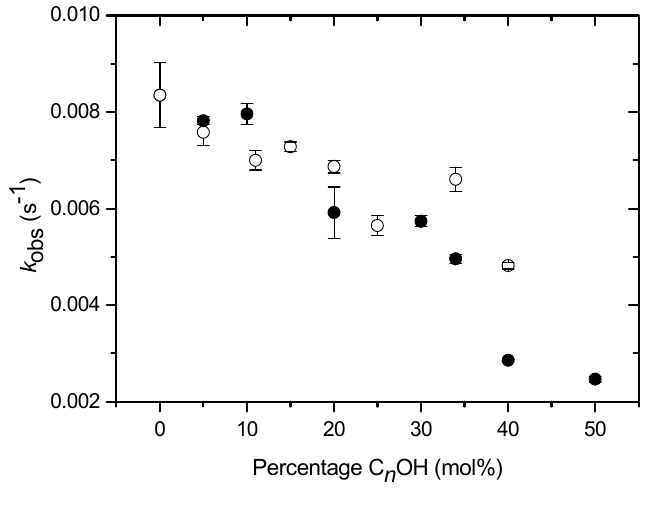
Figure 2. First-order rate constants for the decarboxylation of 1 embedded in DHAB vesicles containing C the standard deviation of at least 5 independent measurements.